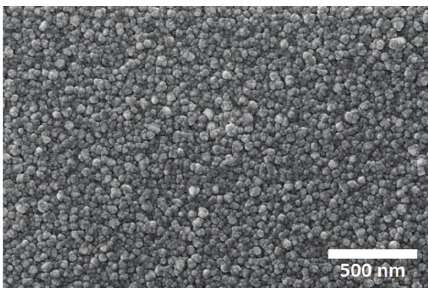
Figure 3: FE-SEM image of the surface of a pm-Si 𝑥 Ge 𝑦 :H film, where the presence of nanoclusters of sizes of about 50 nm is observed.